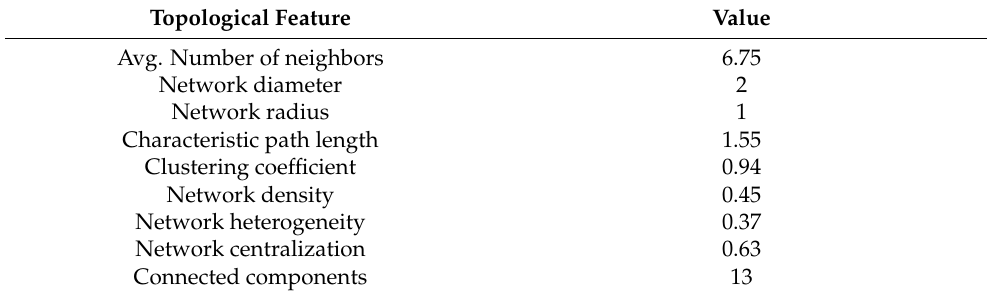
Table 6. The main topological features of the scholarly community of authors on